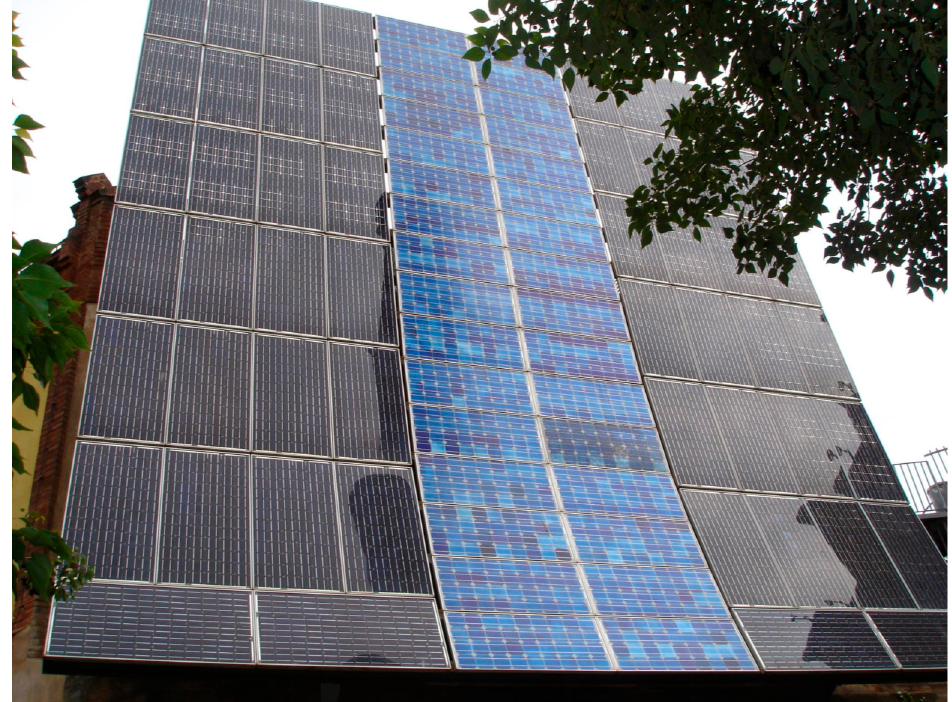
Figure 12. PV modules installed on a structure added to an office building (photo by W. Celadyn).